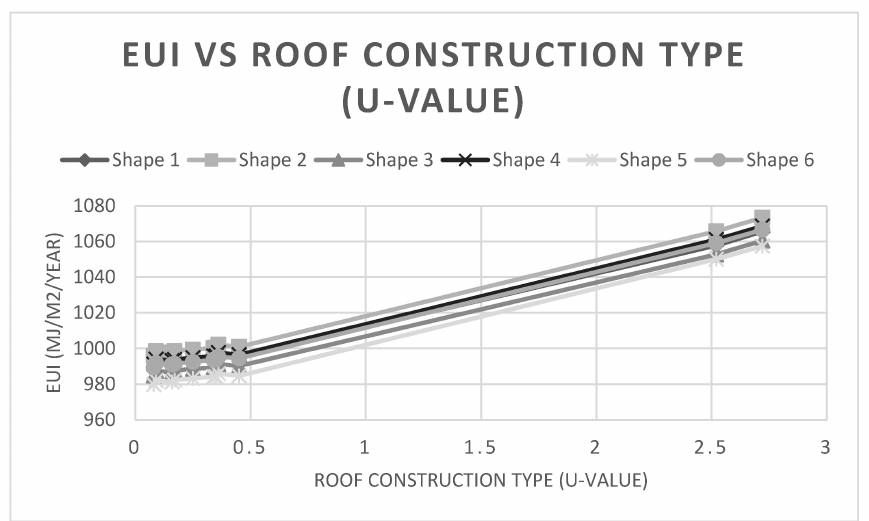
Figure 9. EUI of shapes vs. roof construction type